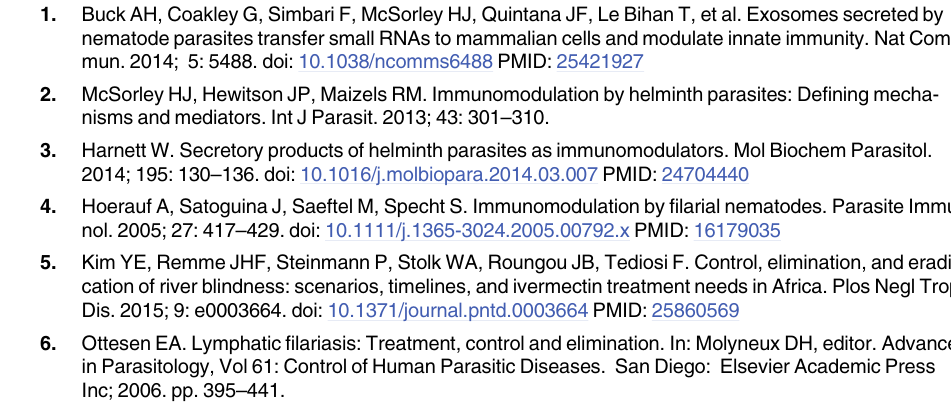
S1 Fig. The effect of serum and heat-treated serum on extracellular DNA release from PMN in the presence of PMA.